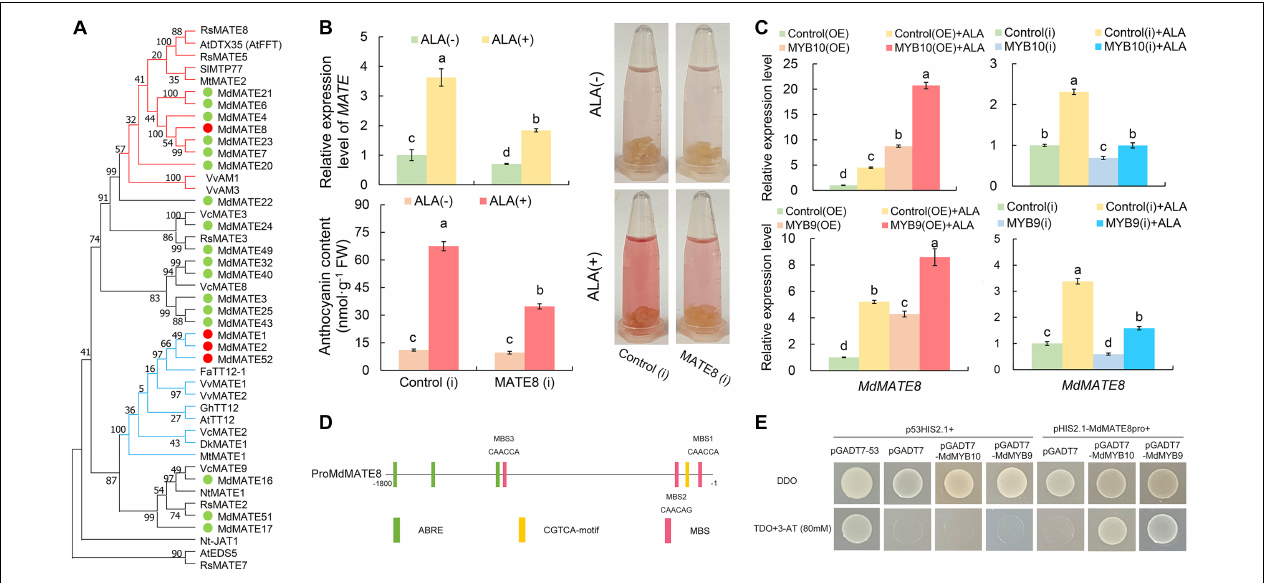
FIGURE 7 | Functional characterization of MdMATE8 . (A) Phylogenetic analysis of MdMATE proteins and selected MATE proteins from other species. (B) The expression levels, colors, and anthocyanin contents in the MdMATE8 transgenic calli with or without ALA treatment. (C) Transcript levels of MdMATE8 in MdMYB10 and MdMYB9 transgenic calli with or without ALA treatment. (D) The promoter region of MdMATE8 . (E) Y1H assay showing the interaction between MdMYB10/MdMYB9 and the MdMATE8 promoter. The constructs p53HIS2.1 + pGADT7-53 were used as the positive control. The constructs p53HIS2.1 + pGADT7, p53HIS2.1 + pGADT7-MdMYB10, p53HIS2.1 + pGADT7-MdMYB9, or pHIS2.1-MdMATE8pro + pGADT7 were used as the negative controls, respectively. The different letters in each gene represent significant differences ( p < 0.05).